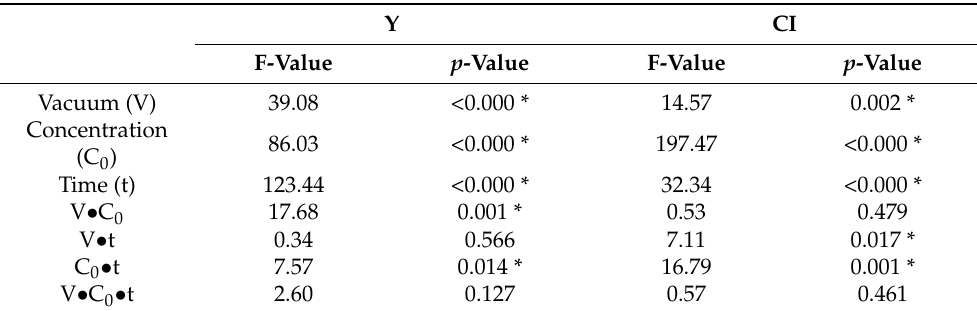
Table 3. Results of ANOVA for solute yield (Y) and concentration index (CI). The asterisk (*) indicates a significant effect ( p < 0.05).